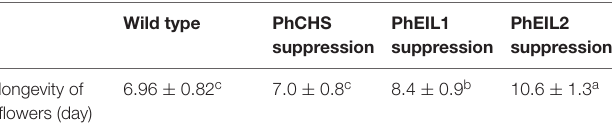
TABLE 1 | The effects of PhEIL1 and PhEIL2 suppression on the longevity of petunia flowers. Wild type